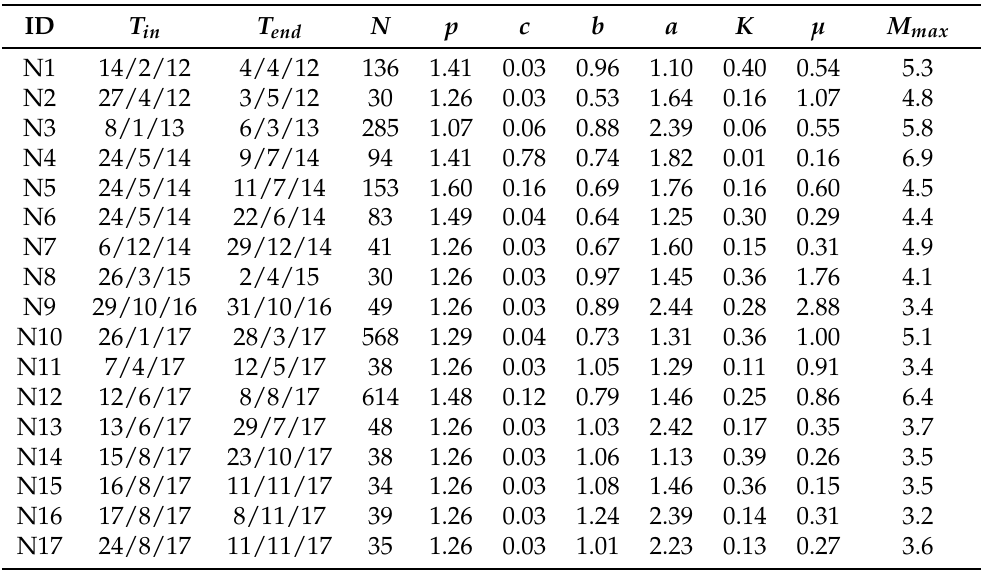
Table 8. Details on the 17 clusters with N ≥ 30 events in NAS area and the inverted ETAS parameters. The generic values of the Omori law, p and c , are adopted for clusters with N < 80.